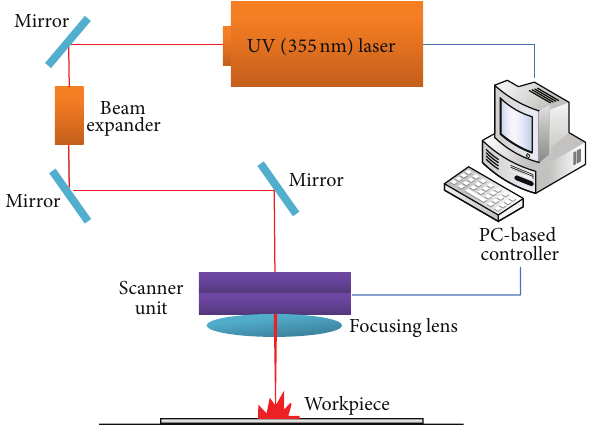
Figure 1: Illustration of laser process route [16].